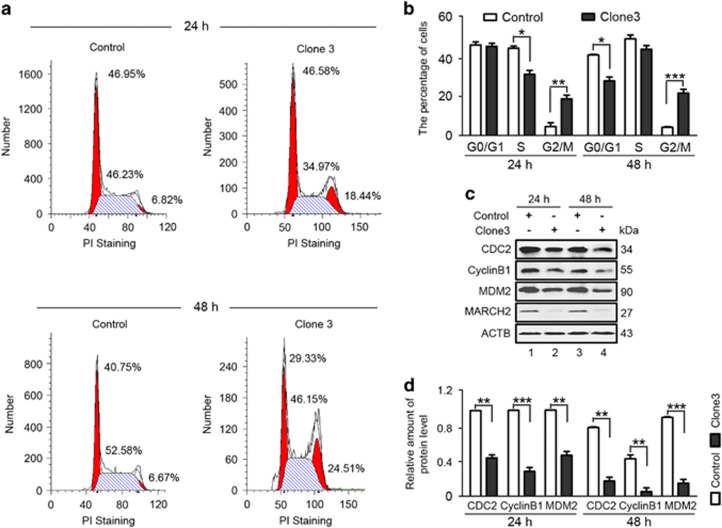
Knockout of MARCH2 induces G2/M phase arrest. (a) Control and Cas9-MARCH2 HCT116 cells were serum-starved for 18 h, and then pulsed with 10% FBS for 24 h or 48 h. Cell cycle distribution was assayed by flow cytometry. (b) Percentages of G0/G1, G2/M and S phase cells. Each bar is mean±S.D. of three independent experiments. (c) Western blotting of the levels of CDC2, Cyclin B1 and MDM2 in the indicated cells treated as described in (a). (d) Quantification of CDC2, Cyclin B1 or MDM2 levels relative to ACTB in cells treated as described in (c). Average value for control cells was normalized to 1. Data are mean±S.D. of three independent experiments. *P<0.05, **P<0.01, ***P< 0.001